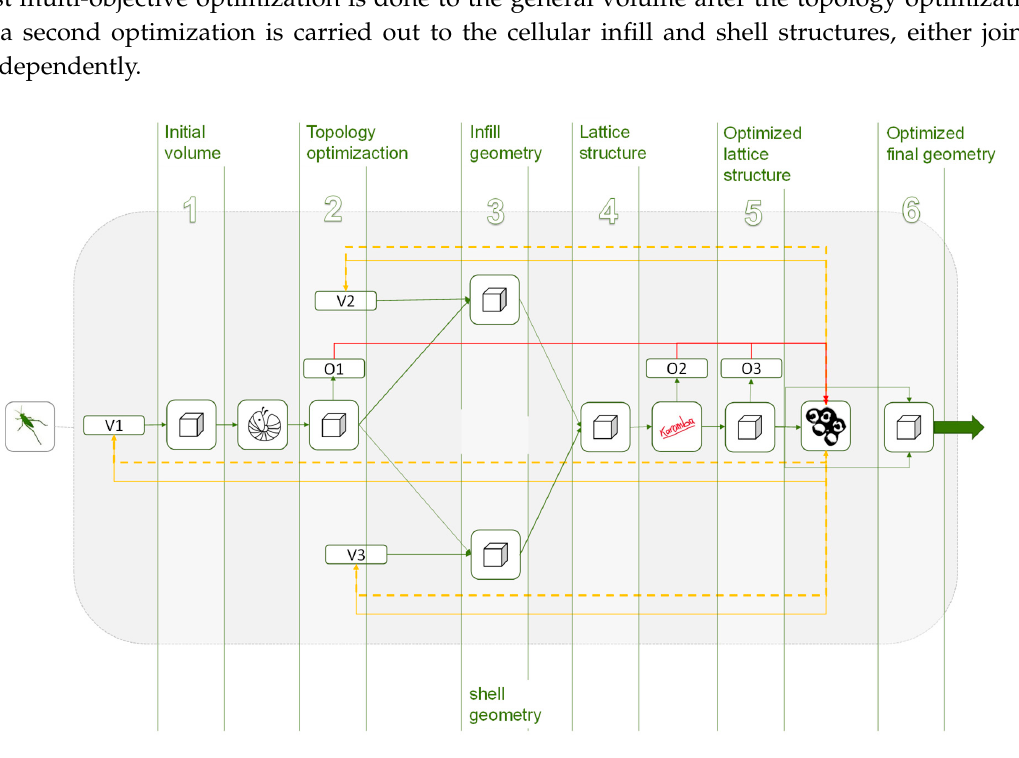
Figure 16. Methodology using a single-optimization solver.